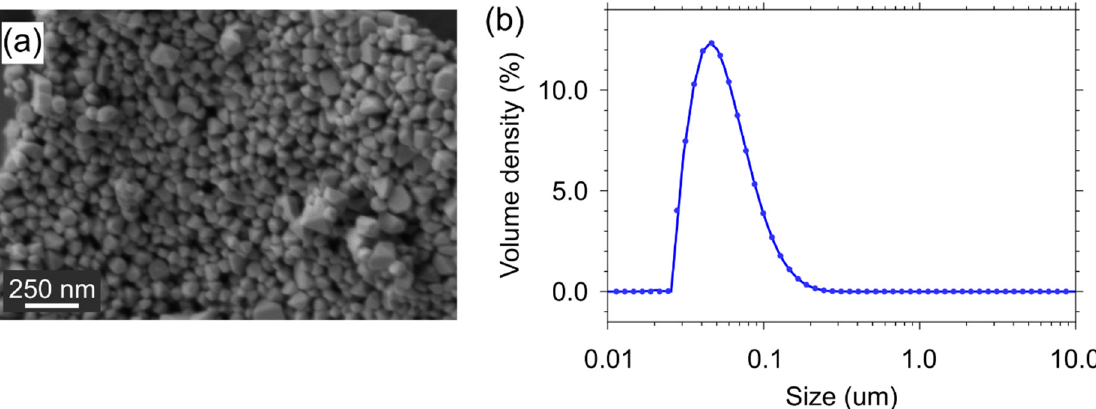
Figure 2. ( a ) SEM image and ( b ) size distribution of the triple-doped YVO 4 : Nd 3+ , Er 3+ , and Tm 3+ particles.